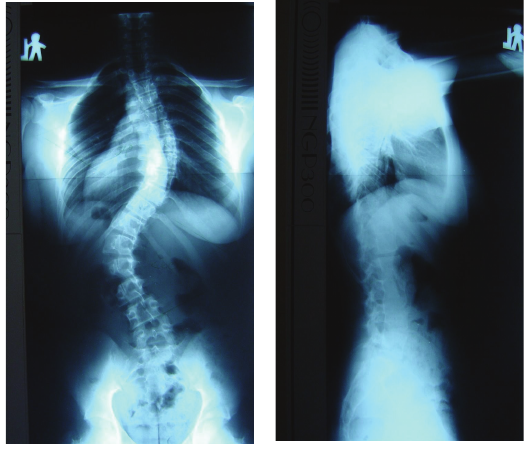
Figure 4: 16 year old girl, treated with Cheneau brace for 1.5 years, including 5 months full time and 1.0 year part time wearing. Tho- racic Cobb angle 54 ◦ , lumbar Cobb angle 60 ◦ , Risser sign 4. Two years after menarche. Main curve ATR = 10 ◦ , sum of three ATRs = 17 ◦ , POTSI = 16.0, HS = 14, (a) raster stereography; (b) radio-